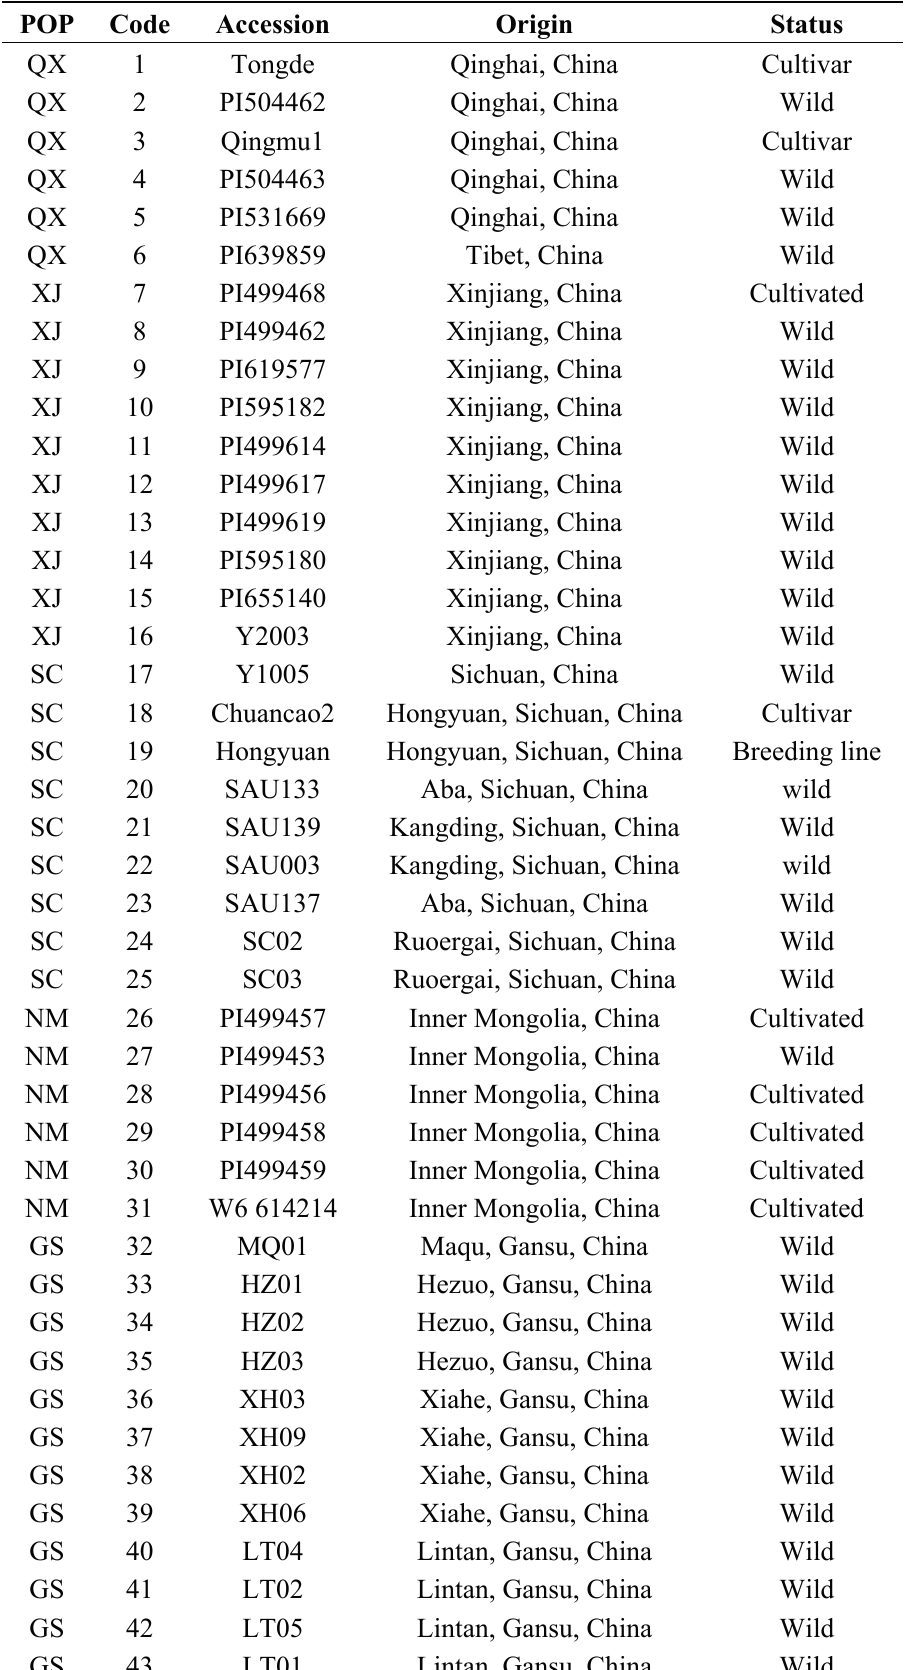
Table 1. E. sibiricus accessions used in the